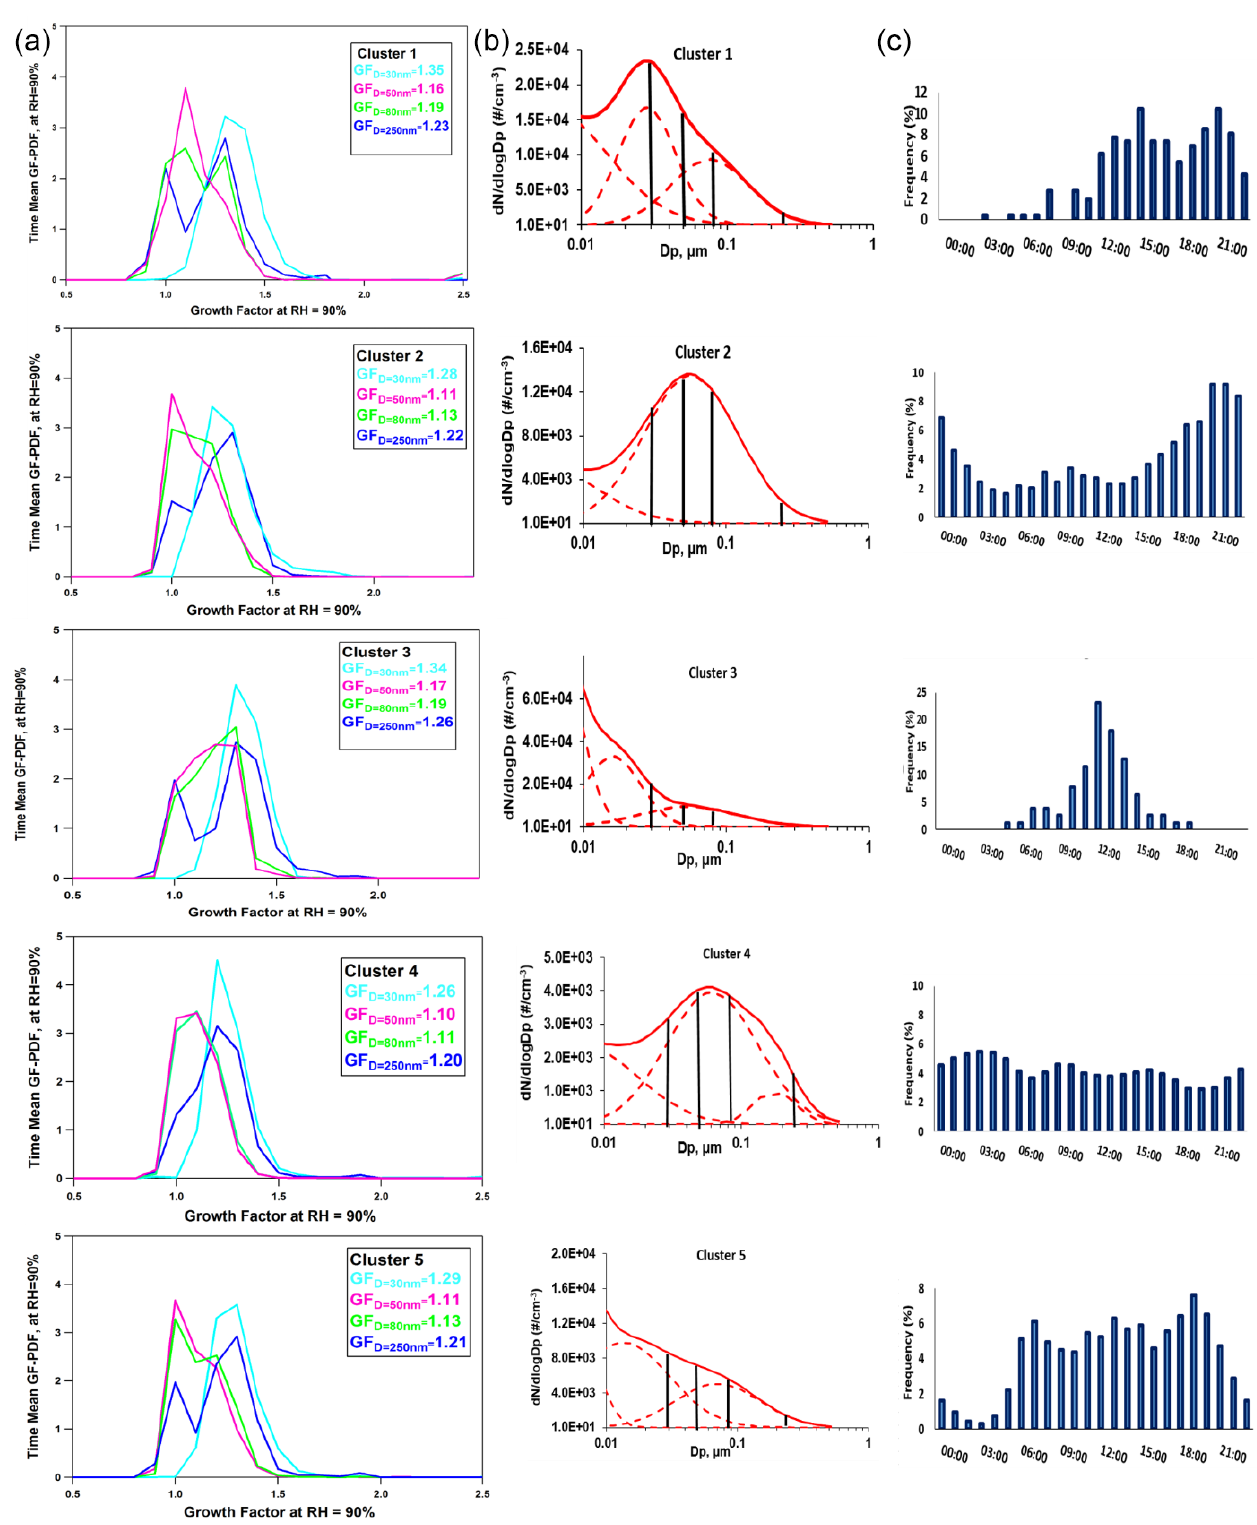
Figure 8. (a) Mean GF-PDF, (b) average number size distribution and (c) hourly frequency of occurrence for each cluster.